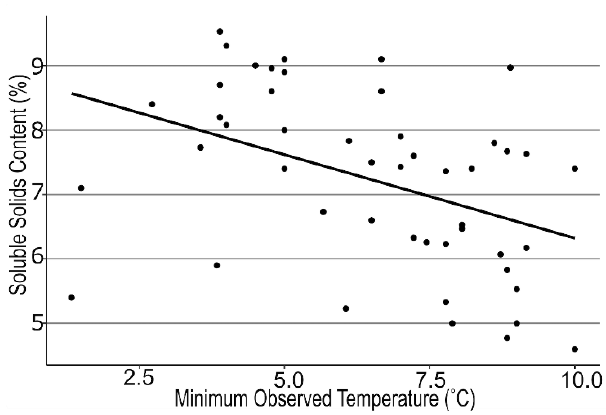
Figure 2. Regression between soluble solids content of strawberry fruit at harvest and the lowest single temperature between first flower and green fruit for 16 farms across New York State visited in 2018, 2019, and 2020. y = – 0.26x + 8.9, r = – 0.42, p < 0.0027.